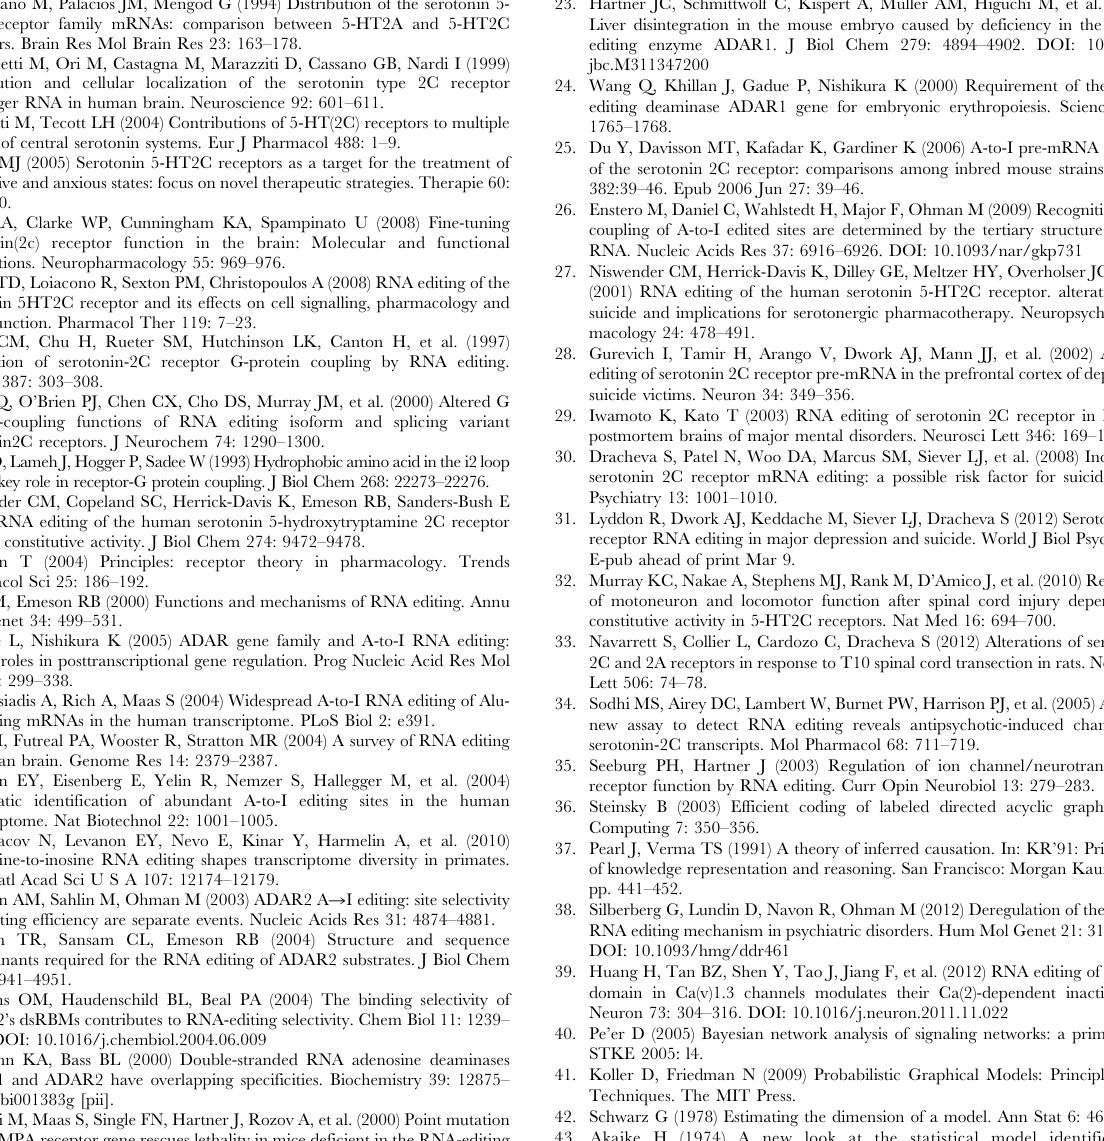
Table S9 Statistics on the individual best-models for Bayes scores in rat. The statistics for Bayes score is very similar to BIC, and we report here only those models for which the Bayes scores behave differently from the BIC scores (changes are in